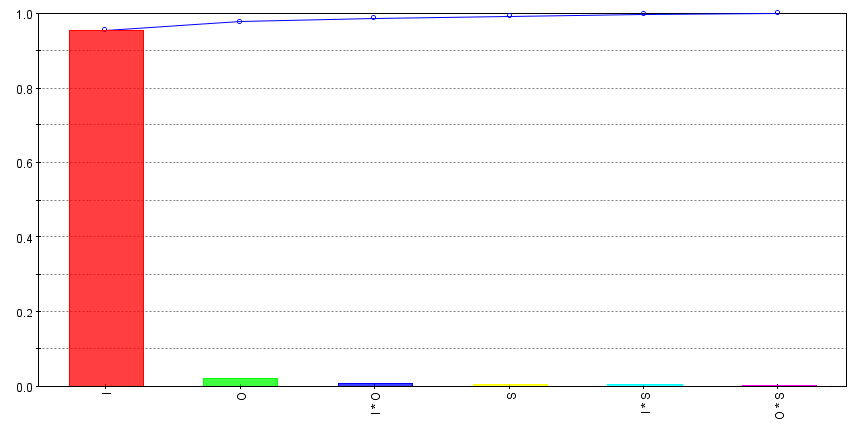
Figure 11. Relative strength of input variables and their interactions for material removal rate ( 𝑅 𝑚 ). The variations in 𝑅 𝑚 with respect to intensity, overlap and scanning pattern are shown in Figure 12. 𝑅 𝑚 increases sharply with intensity levels for all overlaps values and scanning patterns. Results are almost similar for 67 and 75% overlap values and material removal rate is highest with high intensity and low overlap values regardless of the scanning pattern.